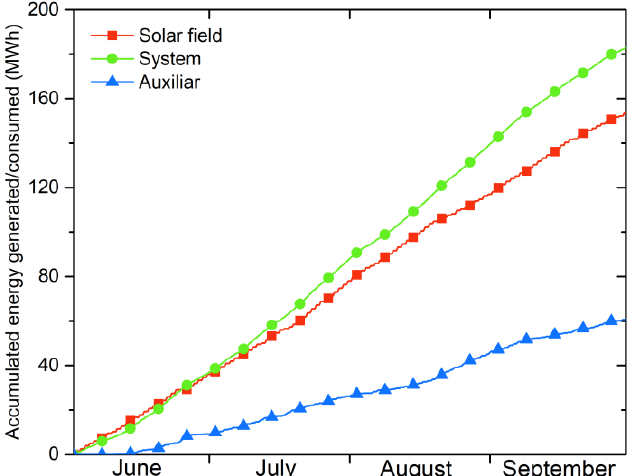
Figure 5. Accumulated energy generated or consumed by the solar field, cooling and desalination system, and auxiliary generator.